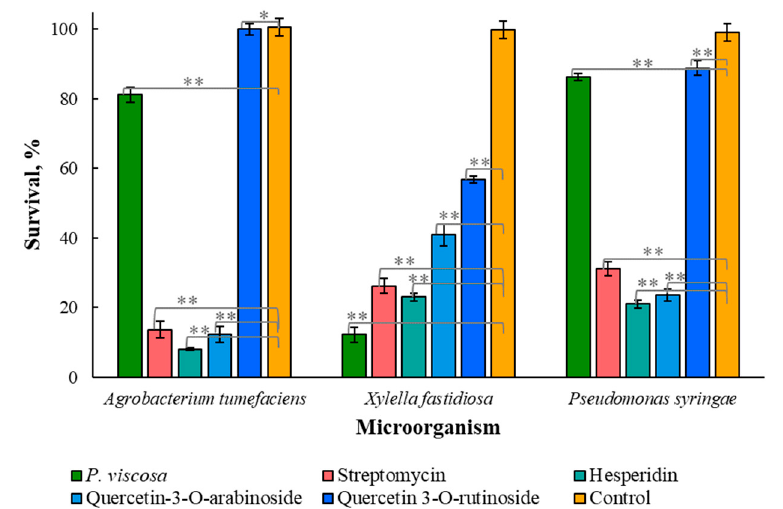
Figure 2. Effect of on eradication of Agrobacterium tumefaciens , Xylella fastidiosa and Pseudomonas syringae . The phytochemicals and streptomycin were at a concentration of 2 µM. Data from three independent experiments are shown. One asterisk designates data of no significant difference, and two asterisks show data of statistically proven difference ( p < 0.001).